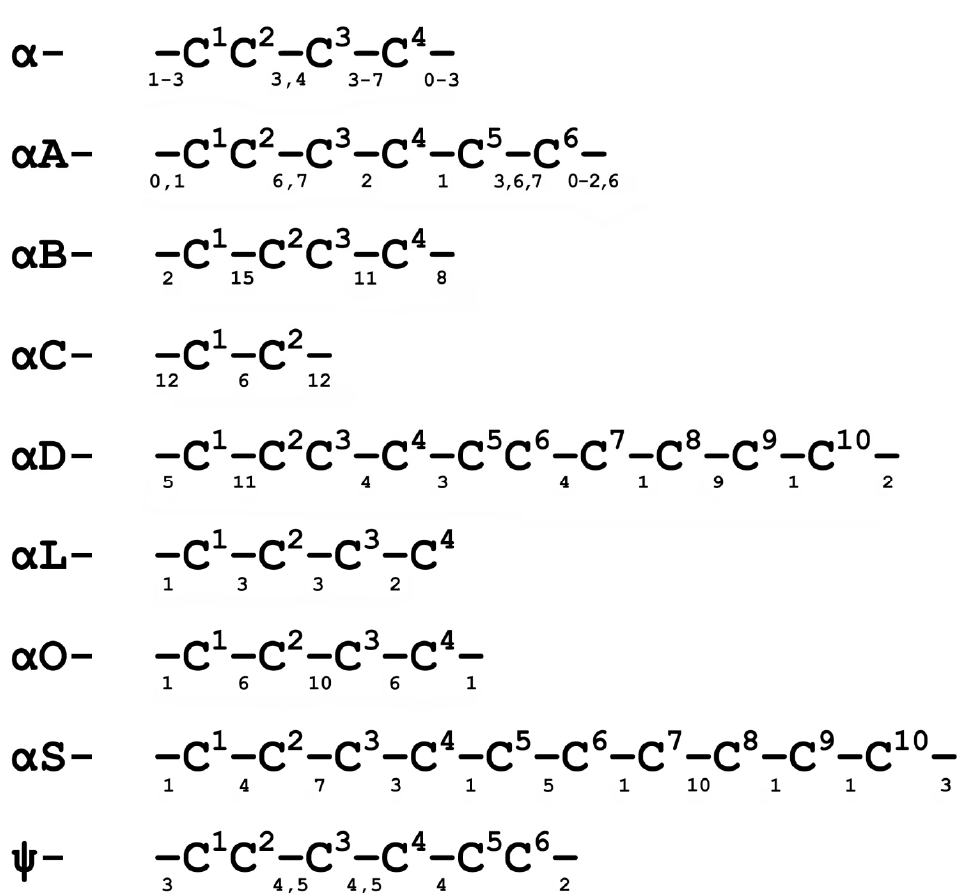
Figure 2. Cysteine framework of the respective conopeptide families targeting nAChRs. The numbers below the dash indicate the number of amino acid residues occurring in native conopeptides between the corresponding cysteine residues.